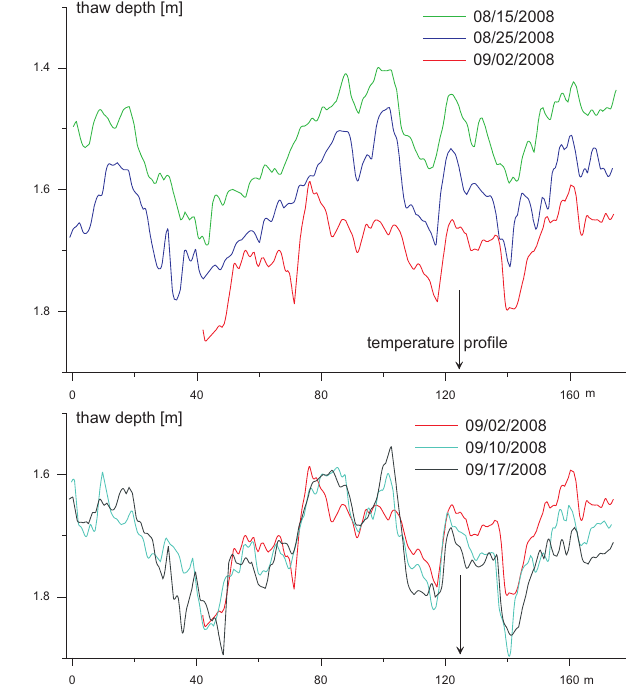
Fig. 4. Transect T1: thaw depth inferred from multi-channel-GPR over a distance of about 95m.